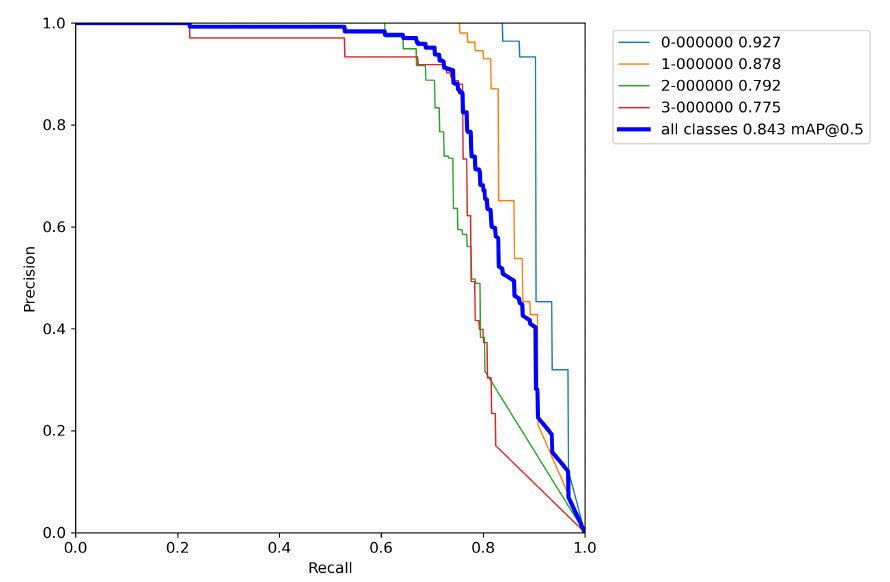
Figure A14. Model trained with augmentation pipeline P–R curve—Experiment 4.